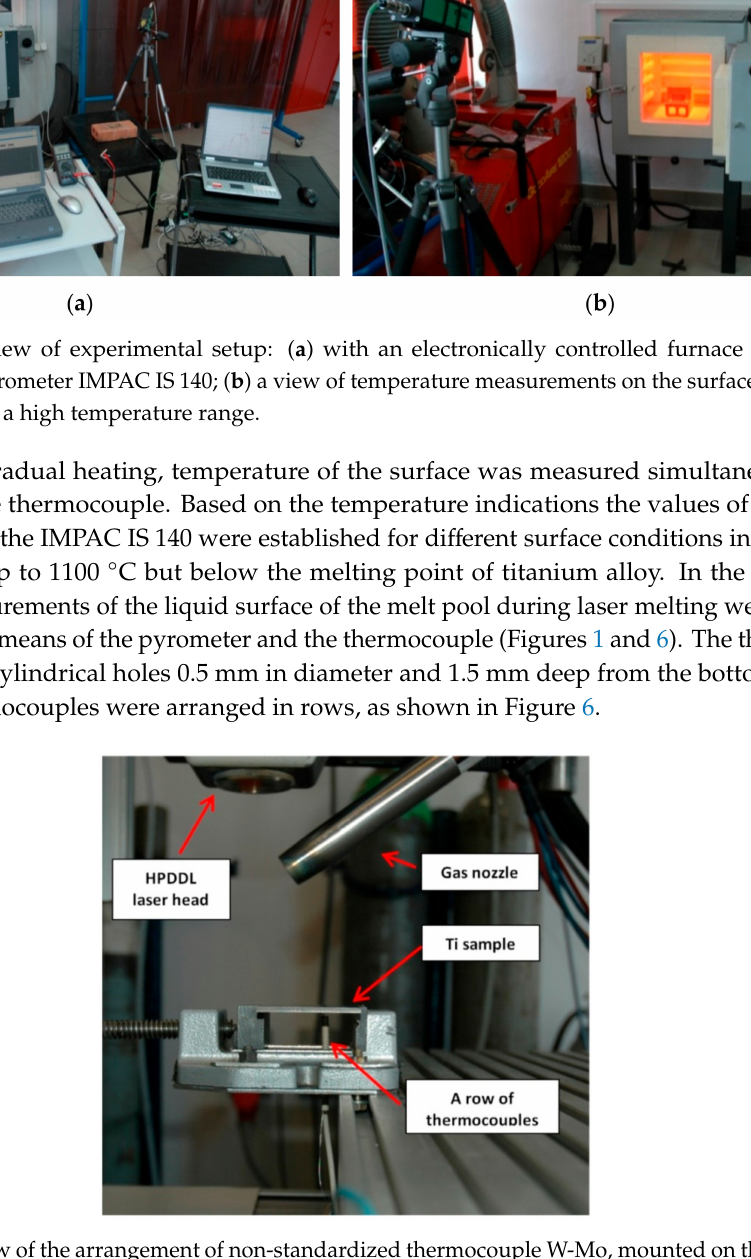
Figure 6. A view of the arrangement of non-standardized thermocouple W-Mo, mounted on the bottom surface of the sample used during the experimental study of heat conditions of HPDDL surface melting and